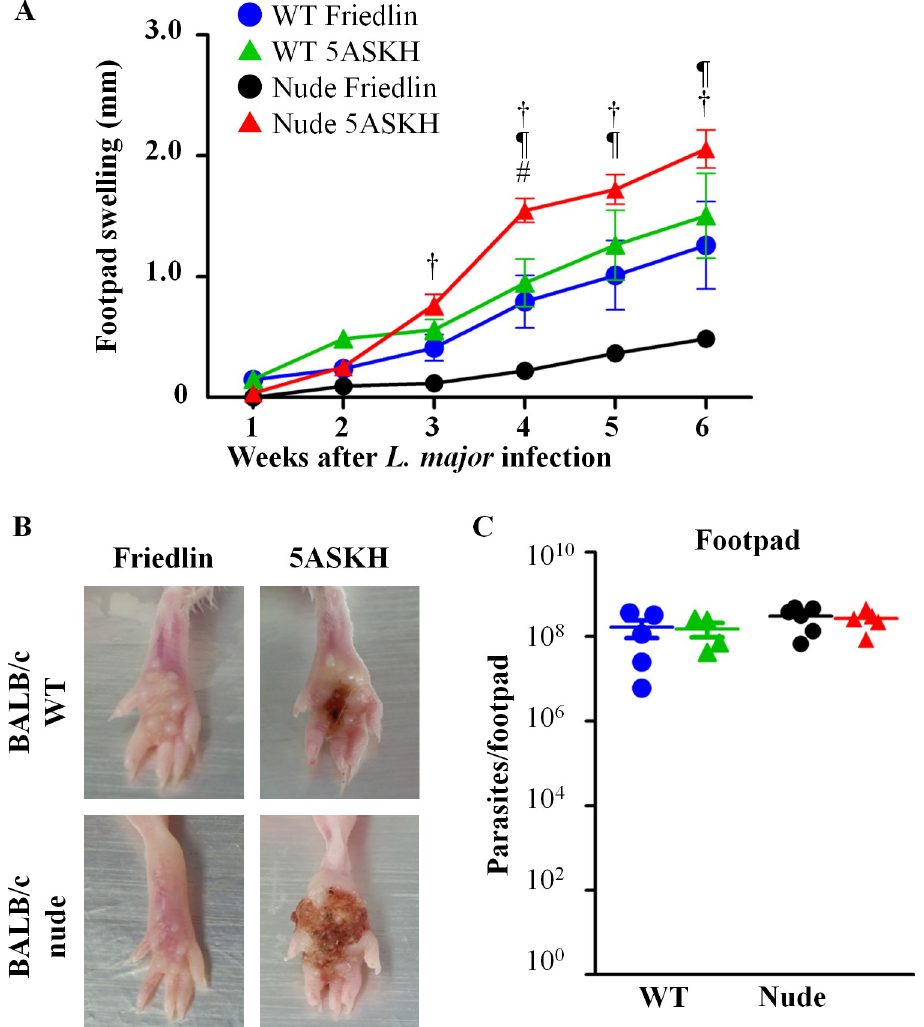
Fig 1. Parasite strain-dependent influence of T lymphocytes on pathogenesis in susceptible BALB/c mice. BALB/c WT and nude mice were infected with 5 × 10 6 stationary phase promastigotes of L . major Friedlin or 5ASKH subcutaneously into the hind footpad. ( A ) Footpad swelling after L . major infection. Each group contains 8–11 mice. All the data are from normal distribution except data of BALB/c mice at 1 and 3 weeks and BALB/c-nude mice at 2 weeks post-infection of L . major Friedlin have deviated from normal distribution. Data deviated from normal distribution were excluded from statistical comparison ( B ) Representative photographs of L . major -infected footpads at 6 weeks post-infection. ( C ) Parasite burden in footpads at 6 weeks post-infection. Each mouse footpad was homogenized in 10 ml culture media and cultured for 3 days then viable promastigotes were counted microscopically. Each group contains four–six mice. Symbols: BALB/c mice infected with L . major Friedlin blue circle or 5ASKH green triangle, BALB/c-nude mice infected with L . major Friedlin black circle or 5ASKH red triangle; Data are the mean ± SEM. Statistical analyses for lesion size by ANOVA. � †¶# means P < 0.05 between BALB/c-Friedlin × BALB/c- 5ASKH: � ; Nude-Friedlin × Nude-5ASKH: †; BALB/c-Friedlin × Nude-Friedlin: ¶ and BALB/c-5ASKH × Nude-5ASKH: